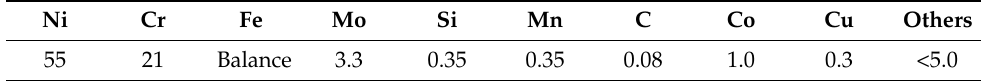
Table 3. Chemical composition of Inconel 718 (wt %) [39].